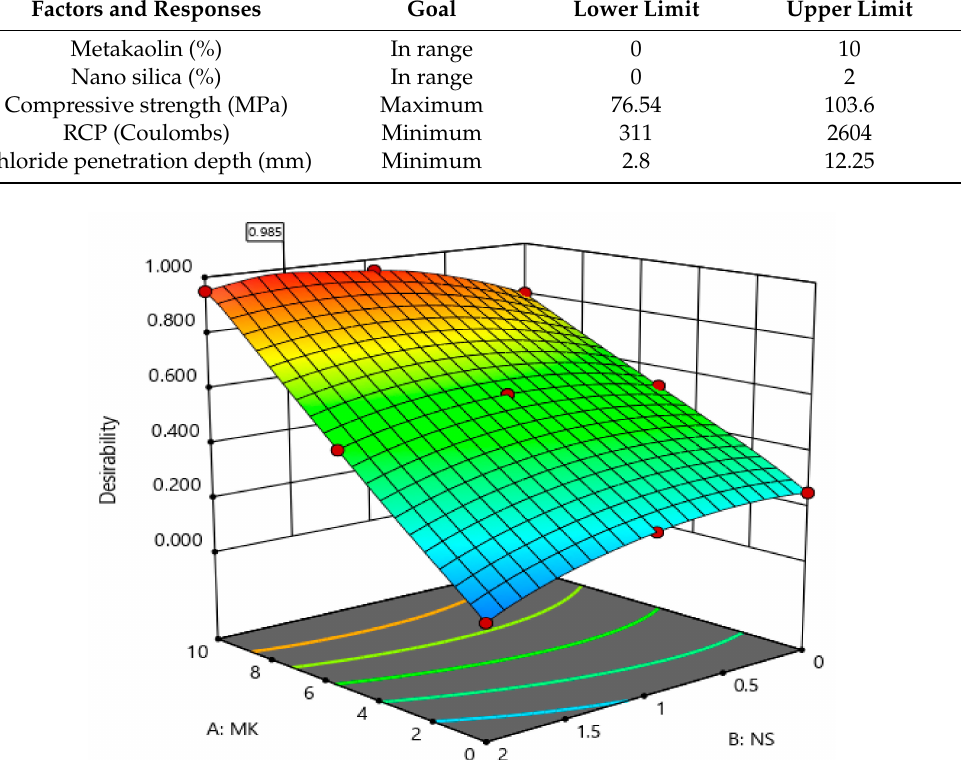
Figure 17. Variation in desirability function based on the multi-objective optimization process on concrete mixes containing MK and NS with